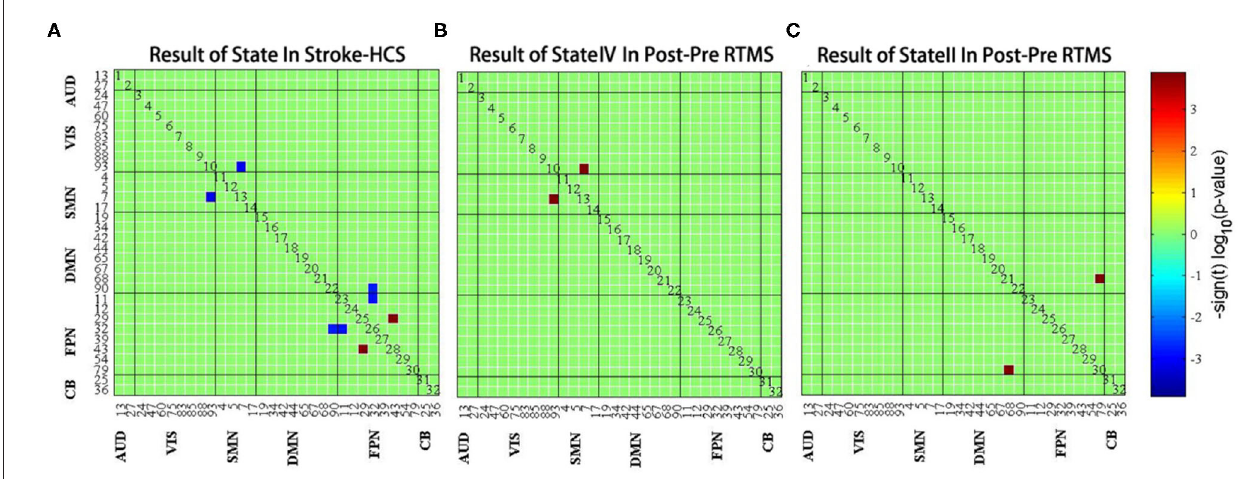
FIGURE 6 | (A) The difference of functional connectivity between healthy controls and stroke group in state IV. (B) The difference of functional connectivity in state IV before and after LF-rTMS treatment. (C) The difference of functional connectivity in state II before and after LF-rTMS treatment. Warm and cool colors indicate increased and decreased